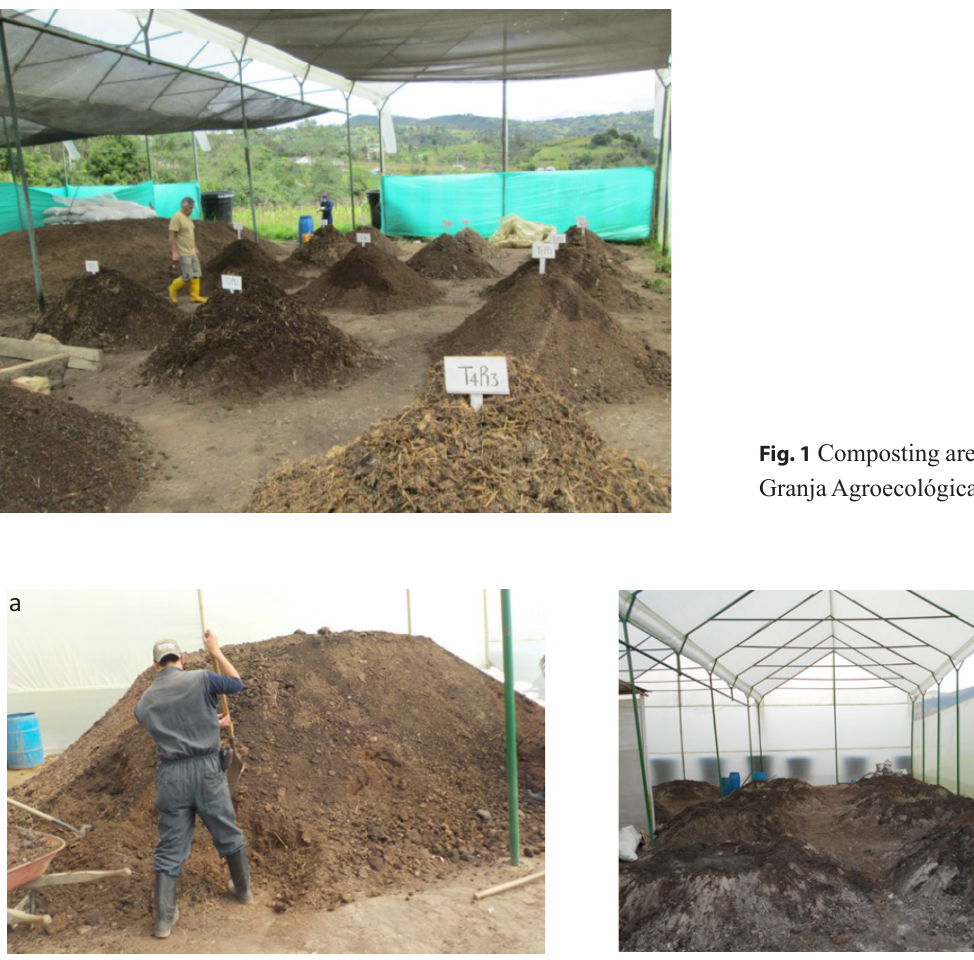
Fig. 2 (a) Mix of cattle manure, equine manure, and poultry manure (1:1:0.26) moistened with mineral fermenta- tion. (b) Distribution of the manure